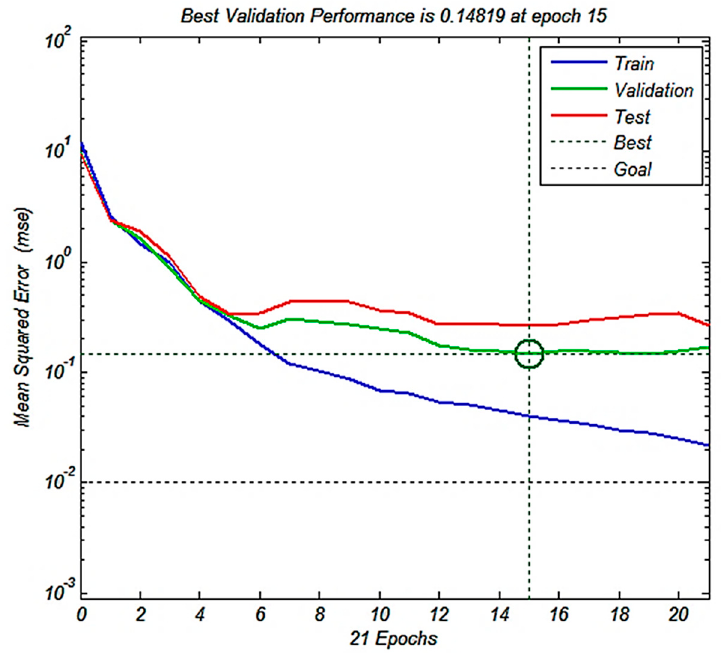
Figure 7. Network performance charts of the scaled conjugate gradient with two intermediate layers and 24 neurons in the first layer and 26 neurons in the second layer.